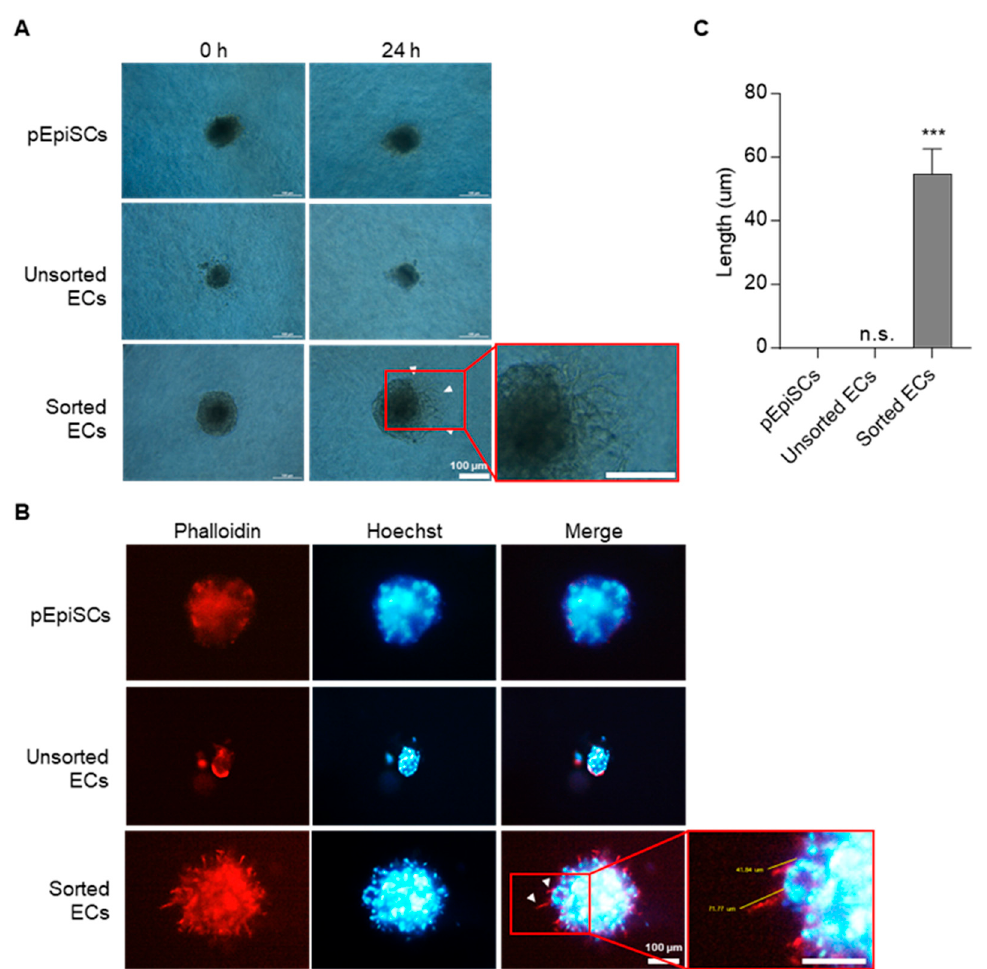
Figure 3. Three-dimensional spheroid sprouting of sorted ECs. ( A ) Three-dimensional spheroids derived from pEpiSCs, unsorted ECs and sorted ECs using the hanging drop protocol were cultured in collagen type I mixtures supplemented with ECGS for 24 h. Arrowheads indicated sprouting (capillary-like) structure out of three-dimensional spheroid derived from the sorted ECs. Scale bar = 100 µm. ( B ) Phalloidin staining in three-dimensional spheroid sprouting. Arrowheads indicated a capillary-like structure (sprouting) out of three-dimensional spheroid derived from the sorted ECs. Blue: staining of Hoechst, Red: staining of phalloidin. Scale bar = 200 µm. ( C ) Sprouts length was calculated by using ImageJ. Values presented as mean SEM. *** p < 0.001 versus pEpiSCs, n.s.: not significant.